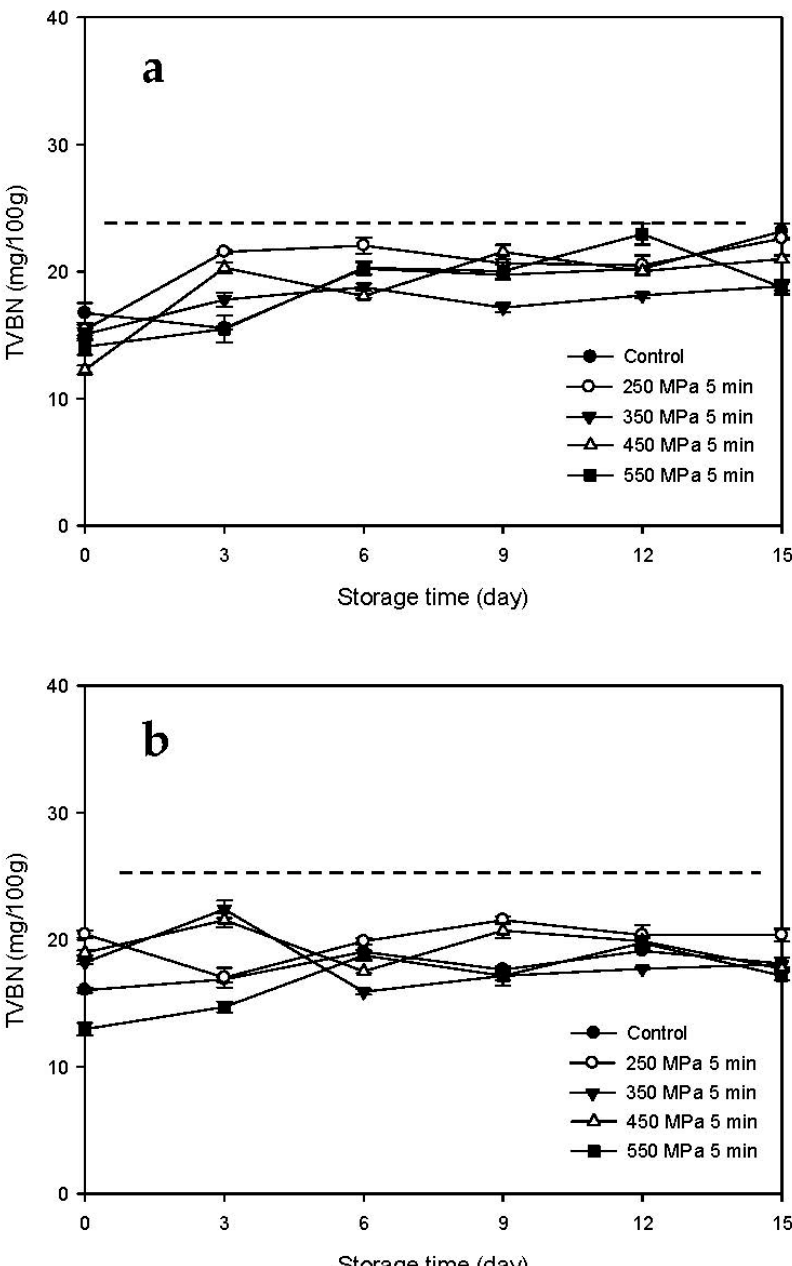
Figure 6. Changes in total volatile basic nitrogen (TVBN) contents of tuna meat samples inoculated with ( a ) Morganella morganii and ( b ) Photobacterium phosphoreum after high-pressure processing treatment at 250, 350, 450, and 550 MPa for 5 min during storage at 4 °C; dash line indicates the sanitation standard for fish products as 25 mg/100 g of TVBN.